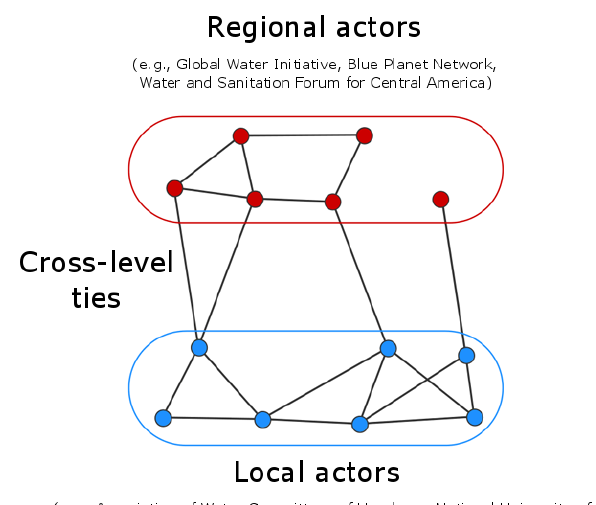
Fig. 1 . Conceptual diagram of a multilevel governance network, including contextual examples of local (blue) and regional (red) water governance actors from Central